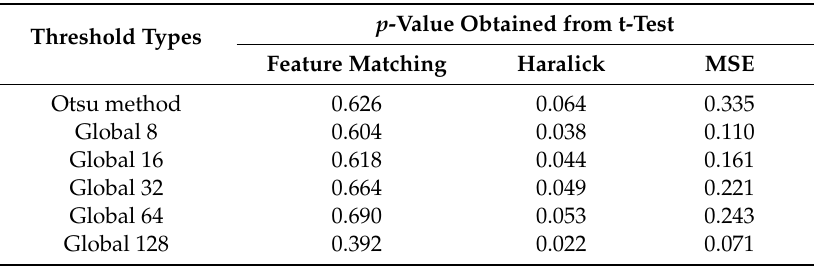
Table 4. p -value changes by threshold